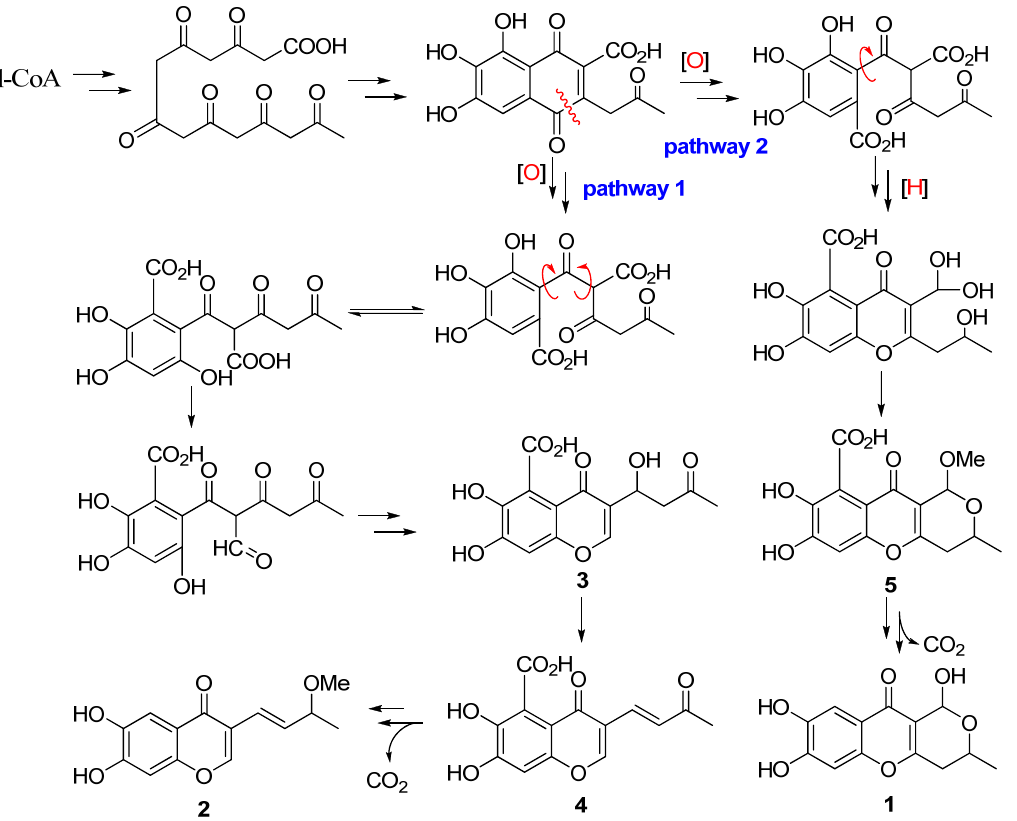
Scheme 1. Putative Biosynthetic Pathway for Compounds 1 – 7